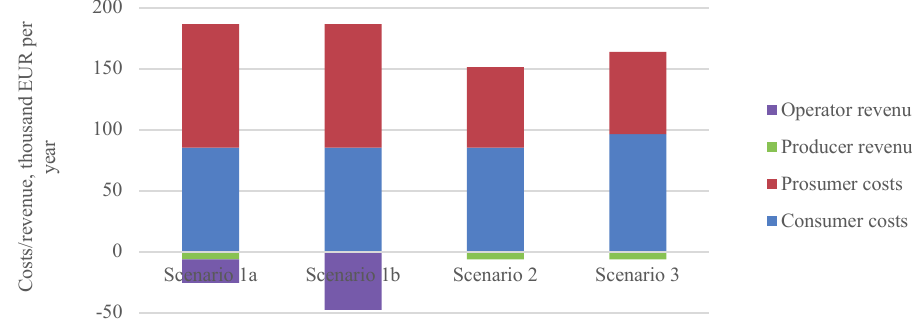
Fig. 6. Main cost and revenues for involved stakeholders under different business models